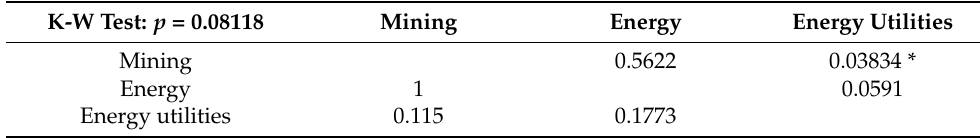
Table 4. Statistical significance of differences in total corporate governance grades, Bonferroni corrected \ incorrected.